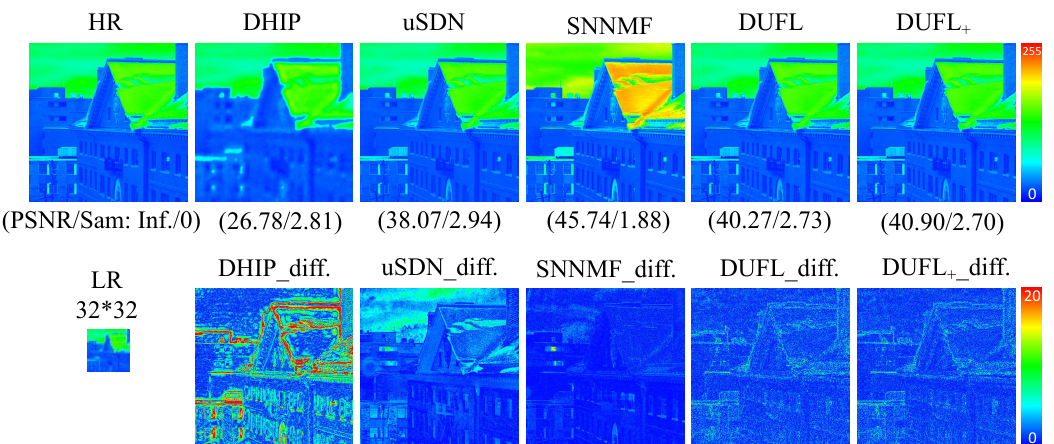
Figure 6. Recovered HR-HS image of the (cid:48) img1 (cid:48) sample in the Harvard dataset using the DHIP [24], uSDN [41], SNNMF [51], and the proposed methods and corresponding difference images between the ground-truth and recovered images with an upscale factor of 8.